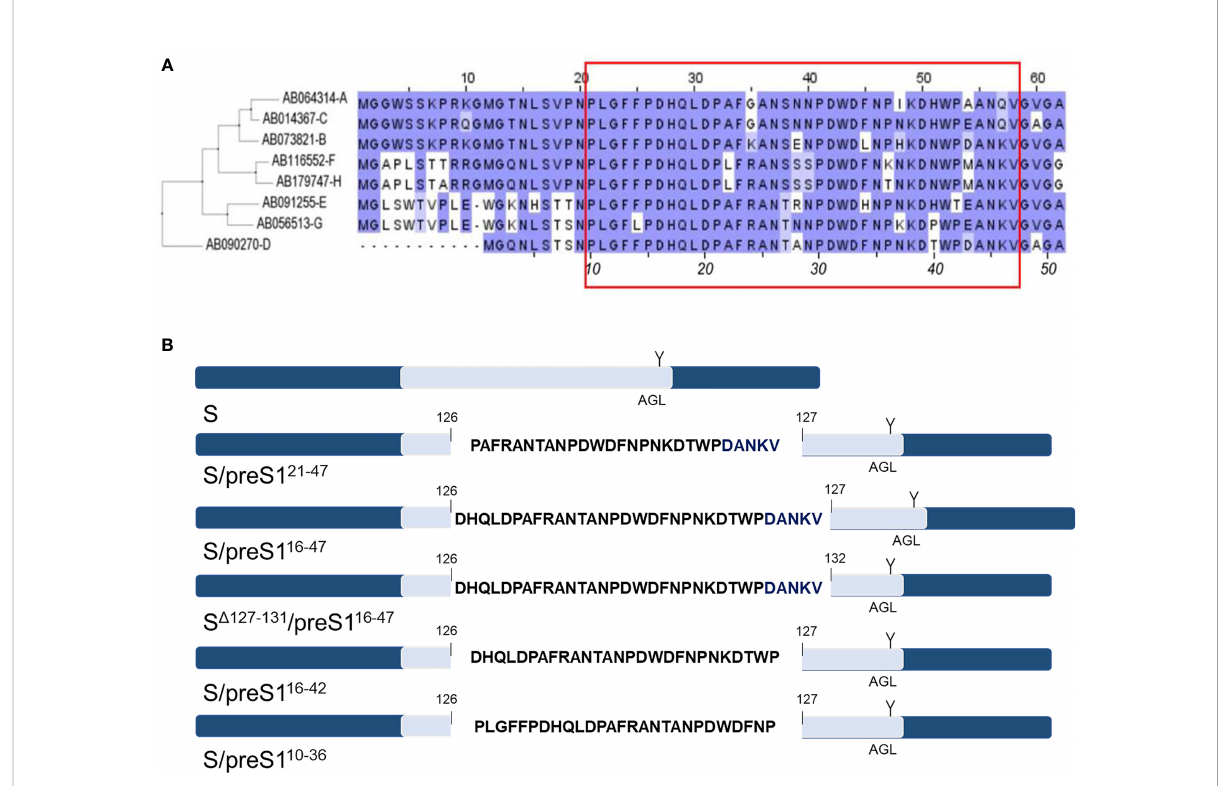
FIGURE 1 Design of novel HBV S/preS1 antigens. (A) The amino acid sequences corresponding to the preS1 region of prevalent HBV isolates were aligned using the Blosum62 matrix. Genotypes A to H are indicated on the left side according to their GenBank annotations. The red box illustrates the preS1 antigenic region which can generate virus neutralizing antibodies (numbers in italics apply to genotype D). (B) preS1-derived sequences were inserted between amino acids 126/127 or 126/132 of the antigenic loop (AGL, depicted in light blue) of the S protein. The unique N- glycosylation site at position N146 of the S protein is also shown